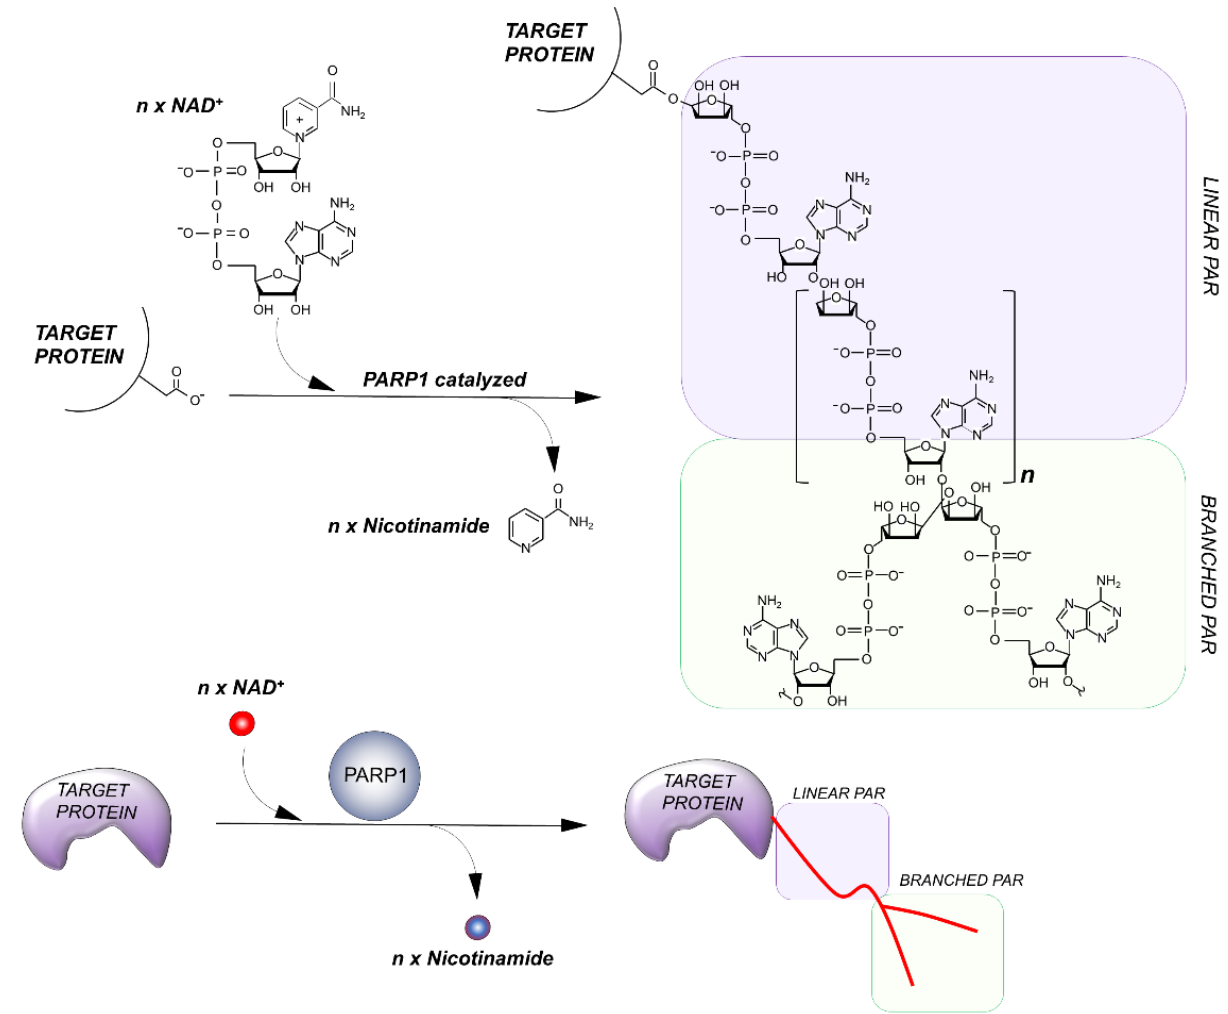
Figure 2. Outline of the PARylation reaction . The elongation reaction results in the production of a linear PAR chain; branching instead induces the rising of collateral branches.